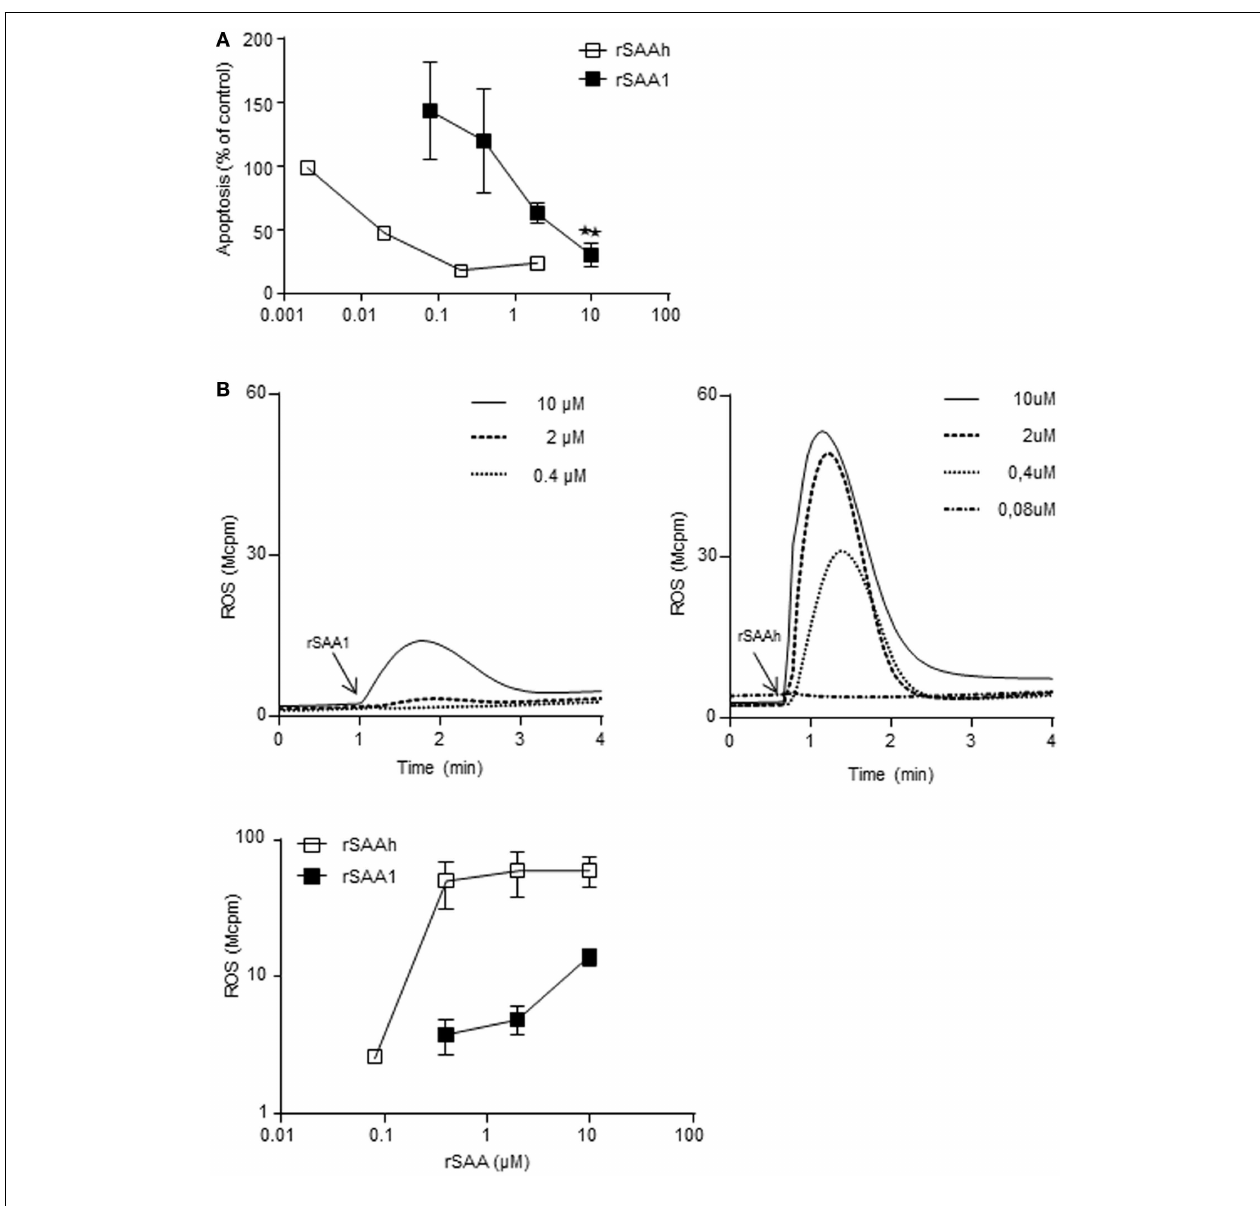
comparison. Statistical analysis was performed using repeated measurement ANOVA followed by Dunnett‘s multiple comparison test ( (cid:63)(cid:63) p < 0.01). (B) Extracellular release of ROS fromTNF- α primed neutrophils after addition (arrow) of indicated concentrations of rSAA1 or rSAAh. Representative curves (upper) are shown with arrows indicating the addition of SAA, as well as mean peak values ( ± SEM; lower) from three independent